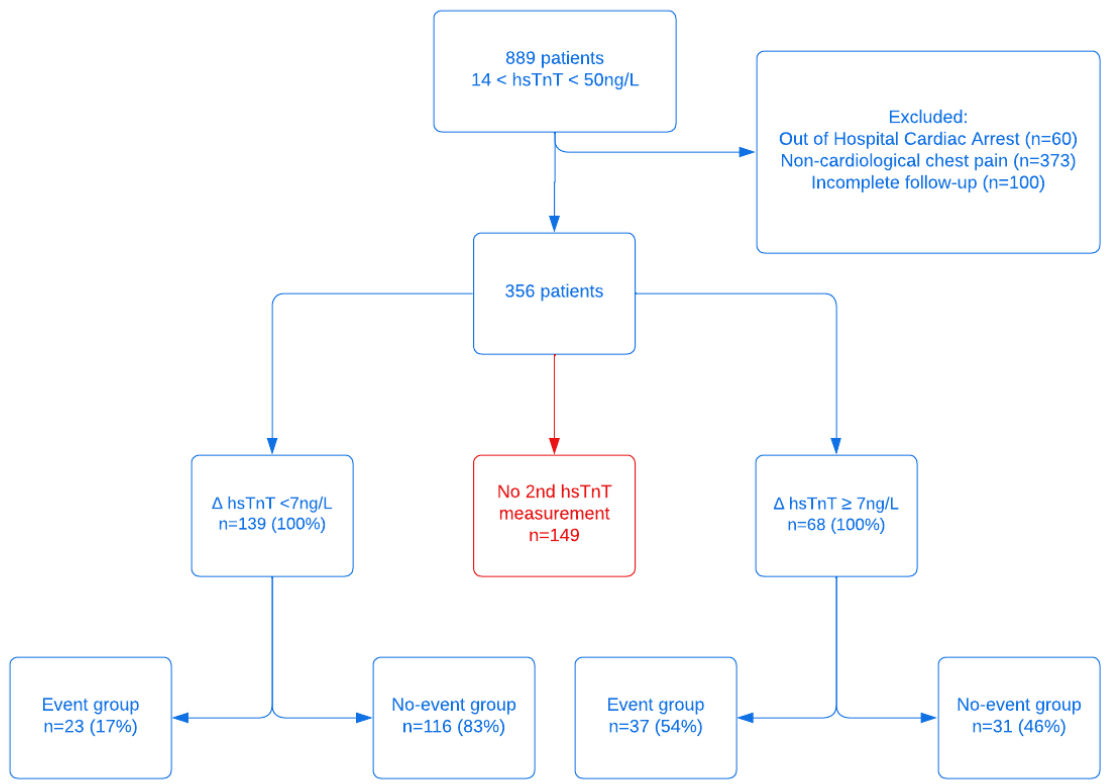
Figure 2. Patient inclusion flowchart. Event is defined as a revascularization within 90 days after initial presentation at the Emergency Department (ED) of the Erasmus MC Hospital.